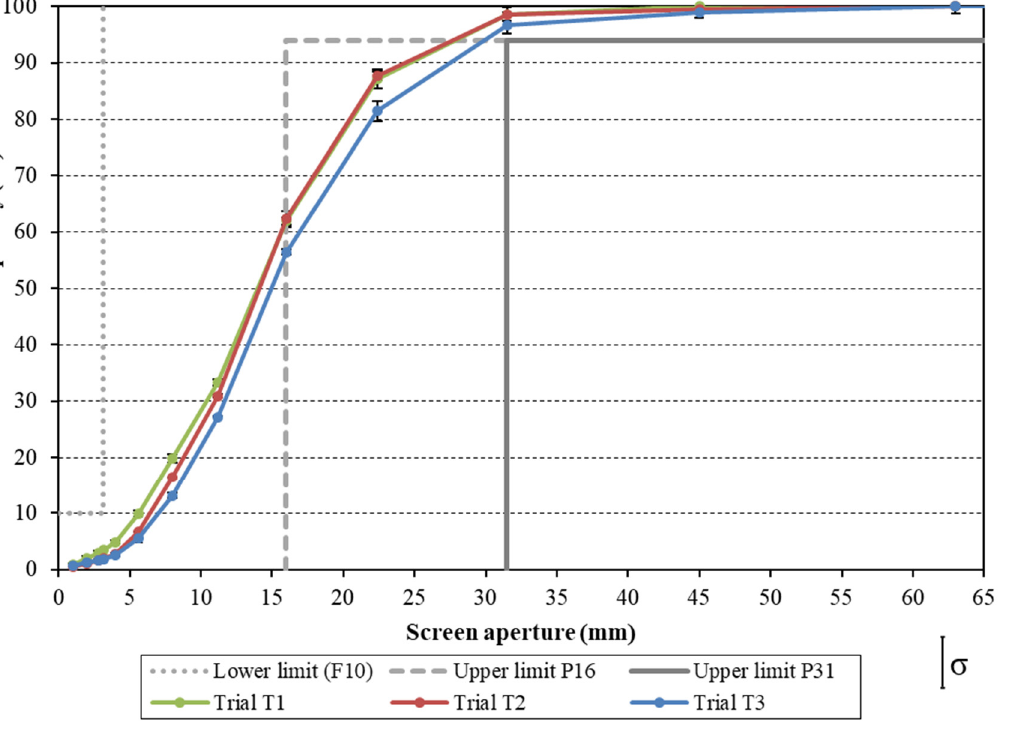
Figure 4. Particle size distribution of wood chips used in the storage trials T1–T3.